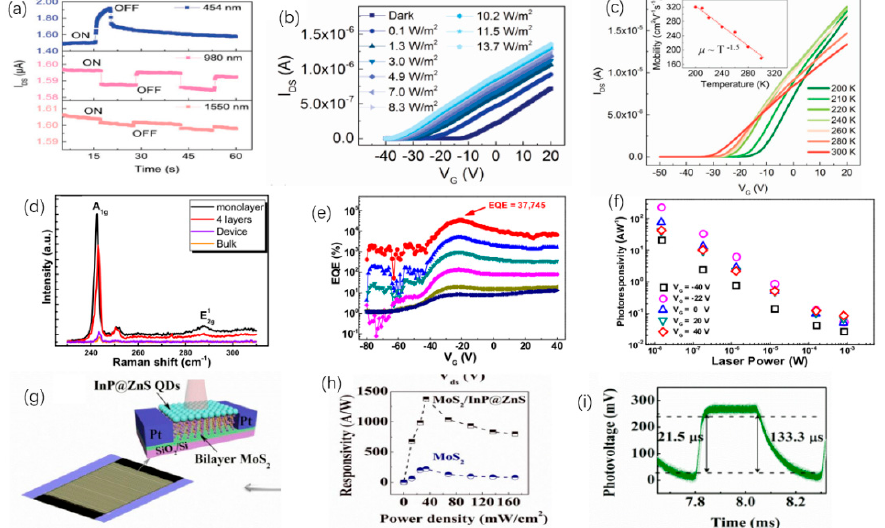
Figure 25. ( a ) Transistor light response excited by light sources in different wavelength bands. ( b ) When the light wavelength is constant, the influence of the ambient light intensity changes to the transistor. ( c ) The influence of temperature changes to transistor in dark environments [314]. Copyright 2018 Wiley-Blackwell. ( d ) Raman spectrum when the number of layers and shape of MoSe 2 change. ( e ) Graph of the influence of laser power and gate voltage on external electron efficiency. ( f ) The influence of laser power on light response rate [315]. Copyright 2017 IOP Publishing Ltd. ( g ) Structure diagram of MoS 2 served as a transistor. ( h ) The relationship curve of light response with power density. ( i ) A light response period curve of a transistor [316]. Copyright 2020 American Chemical Society.